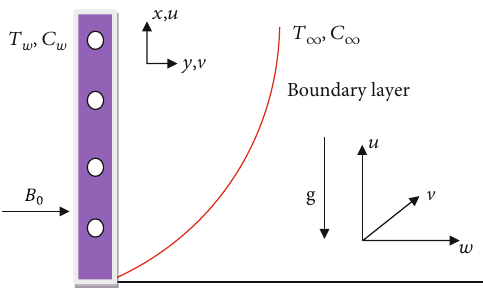
Figure 1: Physical representation of the fl ow